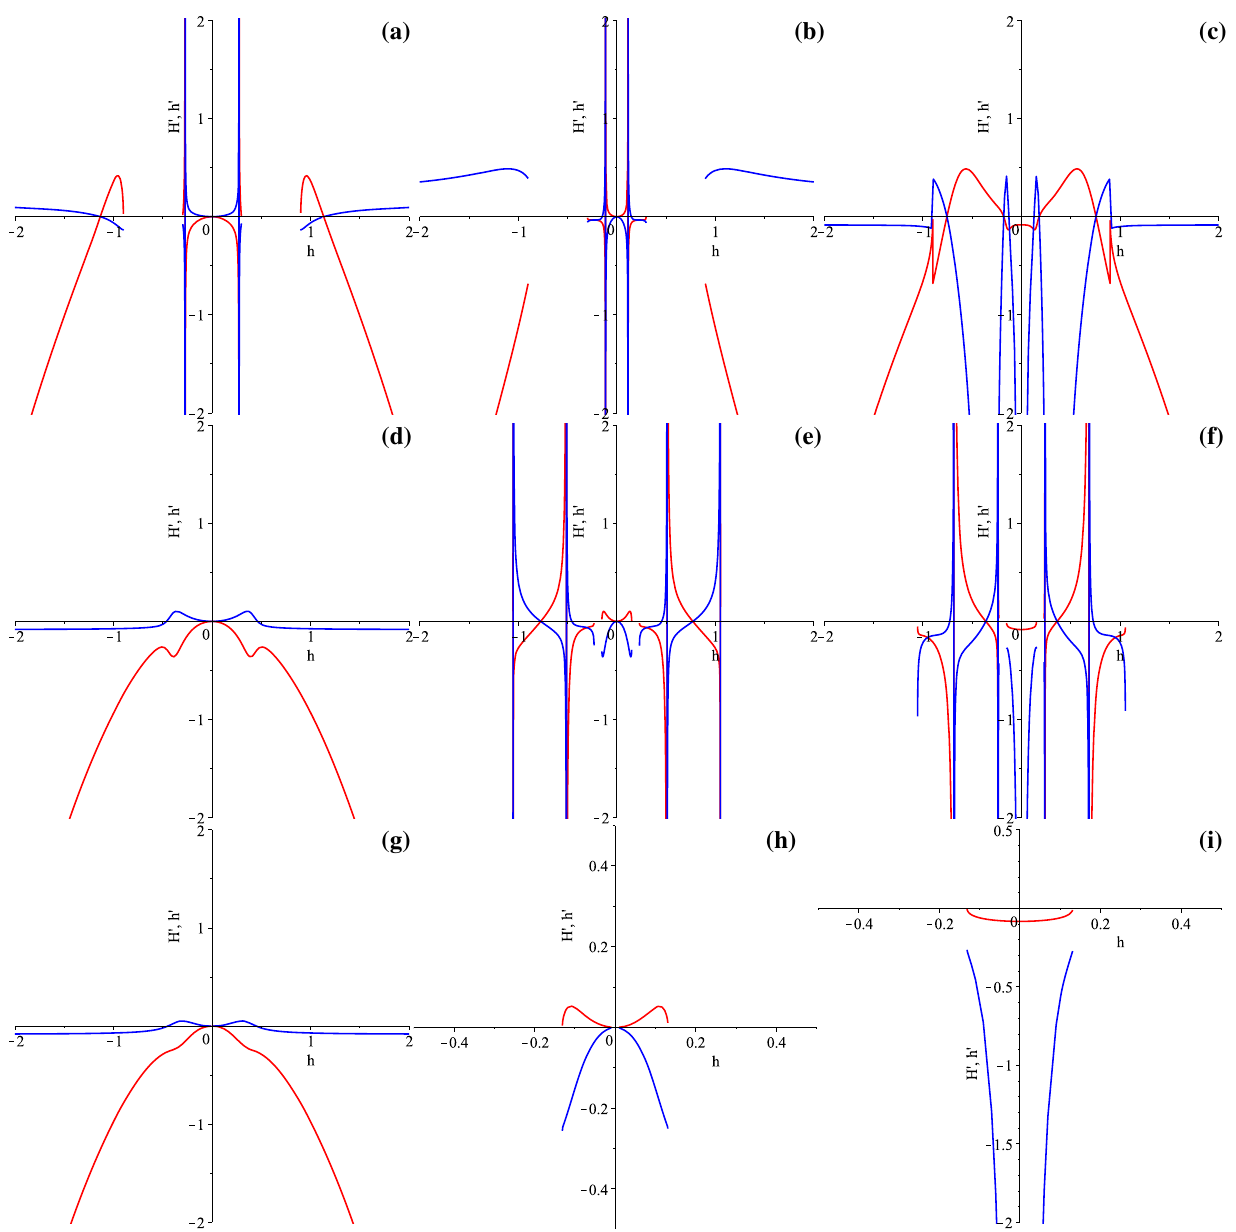
Fig. 3 ˙ H ( h ) and ˙ h ( h ) graphs for vacuum D = 3 case: ˙ h ( h ) in red and on f panel; α > 0, β > 0, μ > 0 . 3 on g – i panels: H 1 branch on g panel, ˙ H ( h ) in blue; α > 0, β < 0 on a – c panels: H H 2 branch on h panel and H 3 branch on i panel (see the text for more 1 branch on a panel, H 2 branch on b panel and H 3 branch on c panel; α > 0, β > 0, μ < 0 . 3 on d – f panels: H 1 branch on d panel, H 2 branch on e panel and H 3 branch